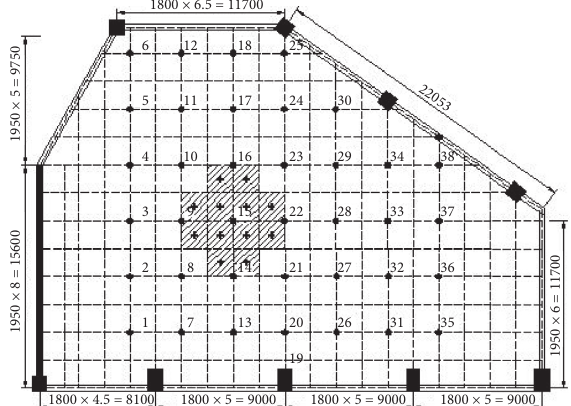
Figure 5: Measuring point layout of the composite floor.